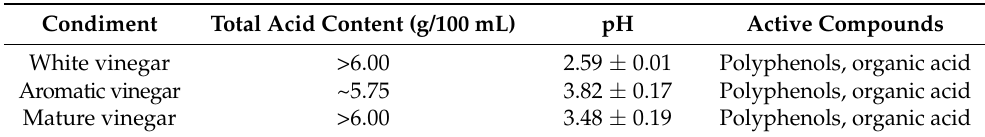
Table 1. The major components of three vinegars.